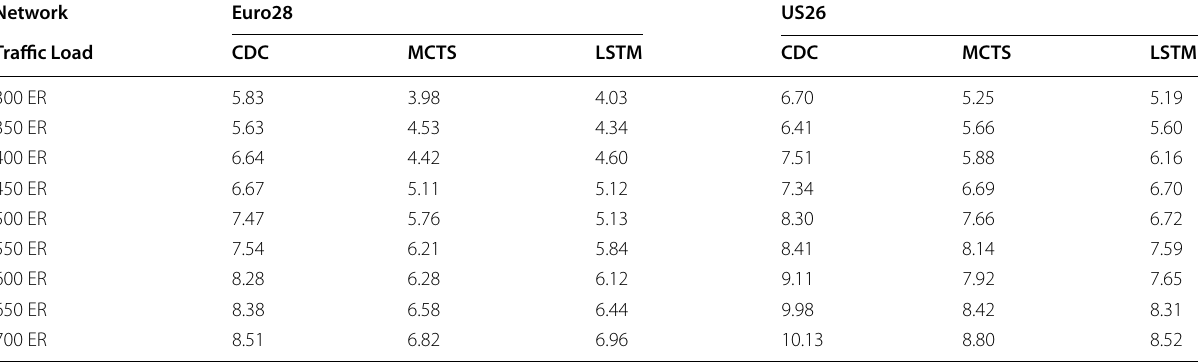
Table 3 Service cost per hour (in Usd), scenario #2